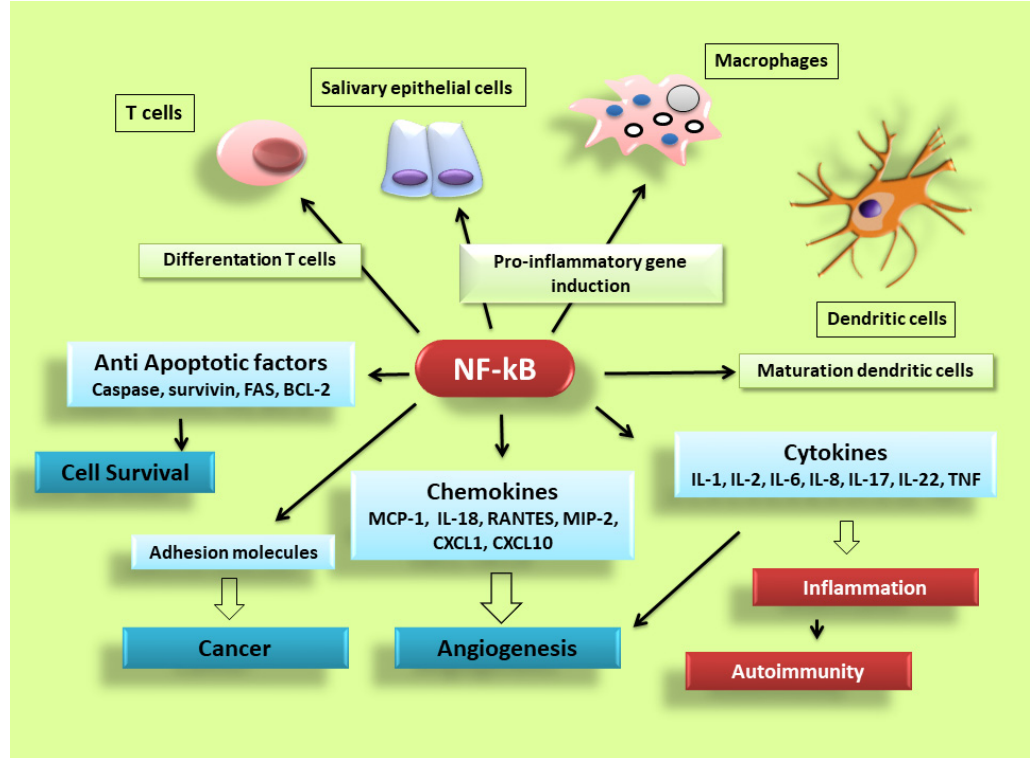
Figure 2. NF- κ B signalling pathway dictates the inflammatory responses. After its activation, it can induce the transcription of a large number of genes including pro-inflammatory cytokines,